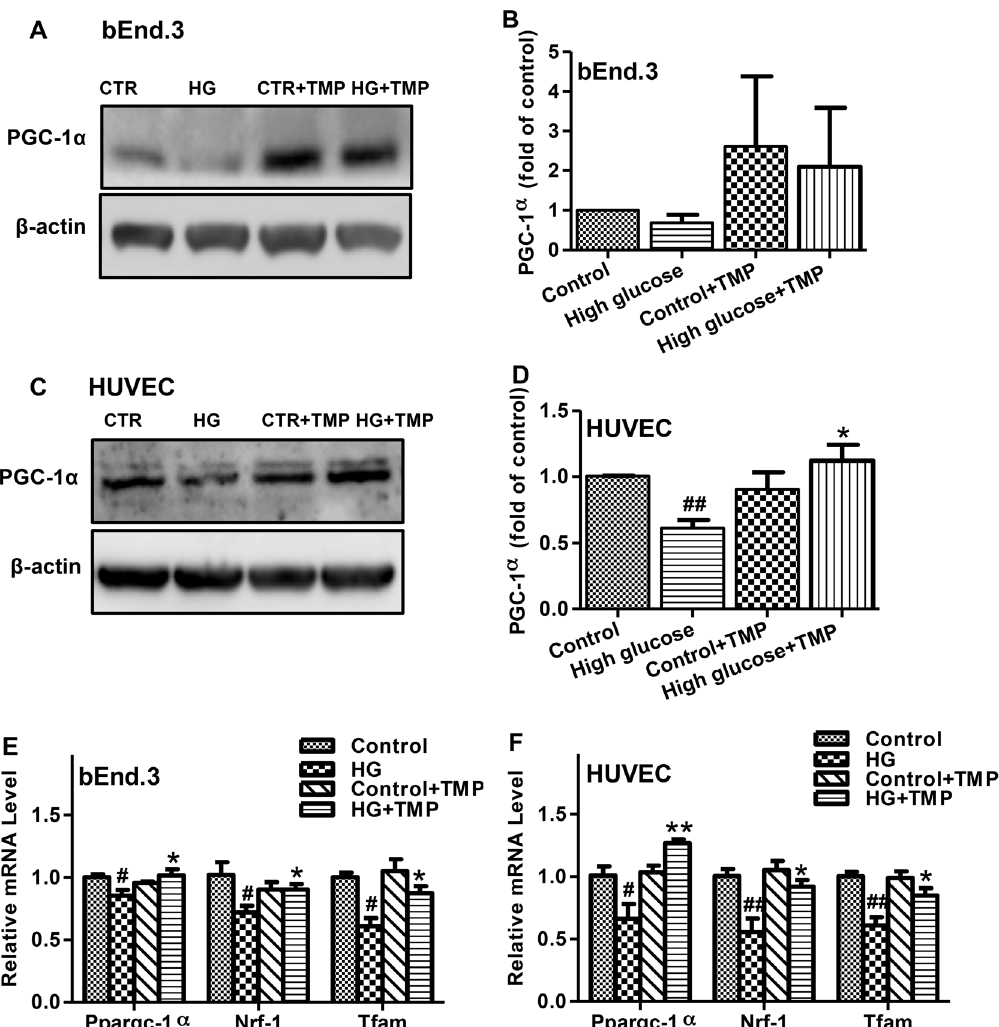
Figure 6. TMP up-regulated mitochondrial biogenesis-related factors. The bEnd.3 and HUVEC cells were treated with Control (5.6 mmol/L glucose, CTR), High glucose (30 mmol/L, HG), Control + TMP (30 m mol/L) and High glucose + TMP (30 m mol/L) for 48 hrs. Levels of PGC-1 a expression were analyzed by Western blotting in bEnd.3 ( A and B ) and HUVEC cells ( C and D ). Representative blots ( A and C ) and quantification data ( B and D ) are shown. Levels of PGC-1 a , NRF-1 and TFAM mRNA were determined by quantitative RT-PCR in the treated bEnd.3 ( E ) and HUVEC ( F ). Data are mean 6 SEM (n=4). # P , 0.05 vs. Control; ## P , 0.01 vs. Control; * P , 0.05 vs. High glucose; ** P , 0.01 vs. High glucose.